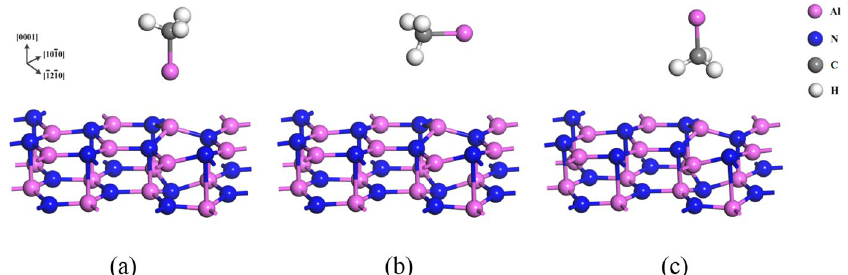
Figure 3. The configurations for AlCH 3 molecule adsorption to the AlN (0001) surface; ( a ) Al atom faces to the surface, ( b ) AlCH